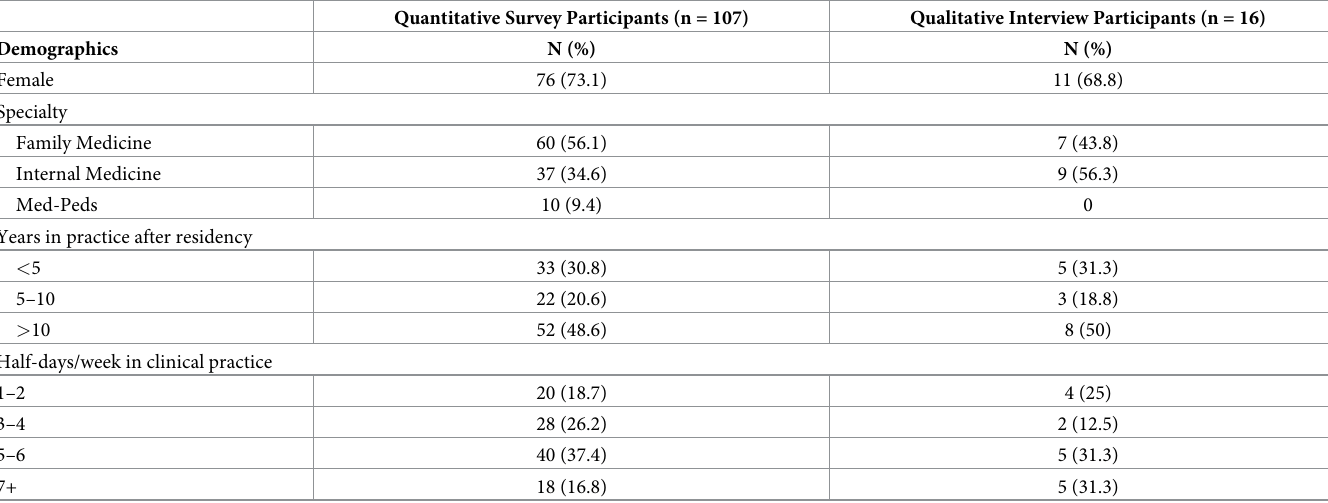
Table 1. Demographic characteristics of survey and interview participants.